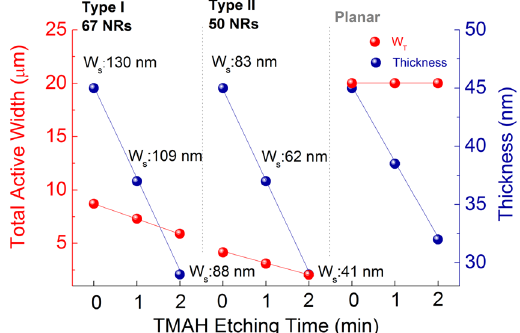
Figure 4. W T and thickness vs TMAH etching time of each substrate. The device width and length are 20 and 10 μ m, respectively. Length is fixed to 10 um for all TFTs. 67 NRs ( W s / T : 130/45 nm) and 50 NRs ( W s / T : 83/45 nm) are made within the device width. W T was calculated by multiplying W s by the number of NR for each